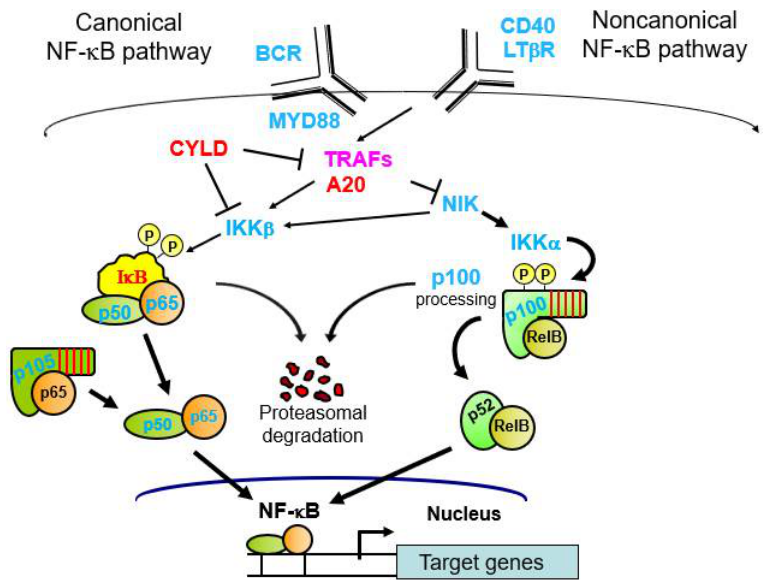
Figure 2. Canonical and noncanonical NF- κ B pathways. Shown are the two most common NF- κ B pathways, including several of the pathway components that are affected by mutations in cancer. Blue font, affected by gain-of-function mutations; red font, affected by loss-of-function mutations; purple font, affected by both gain- and loss-of-function mutations. See text for more details.